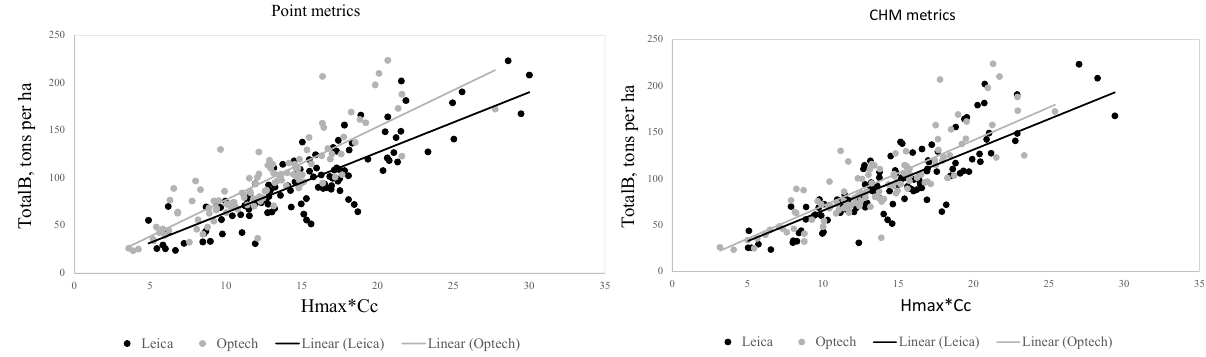
Figure 1. Graphical illustration of the difference in the relationship between Total and the point metrics ( left ) or the CHM metrics ( right ) derived from the two different